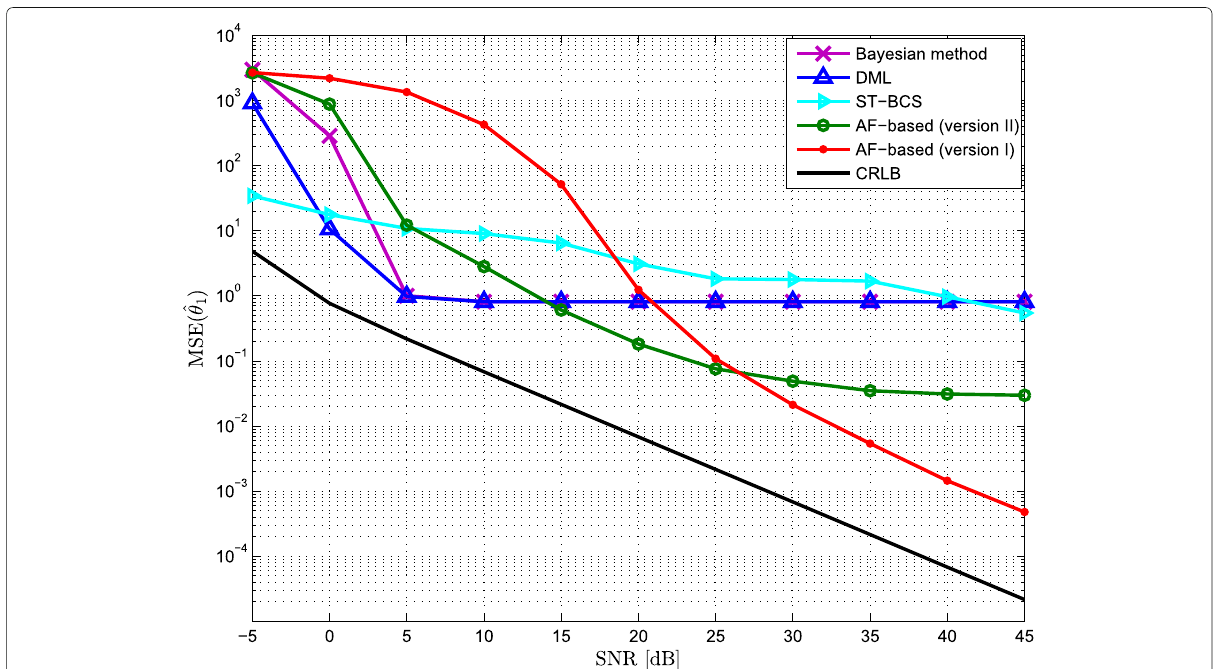
Fig. 4 MSE for the first DOA versus the SNR with K = 2 sources, N = 1, θ 1 = 20.7°, θ 2 = 40.5°, N a = 16 antenna elements, and 16 −